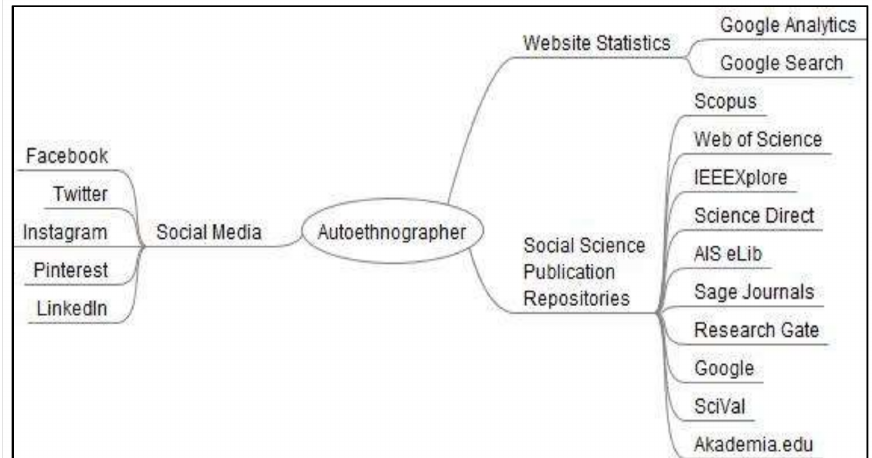
Figure 1. Potential sources of data for academic personal